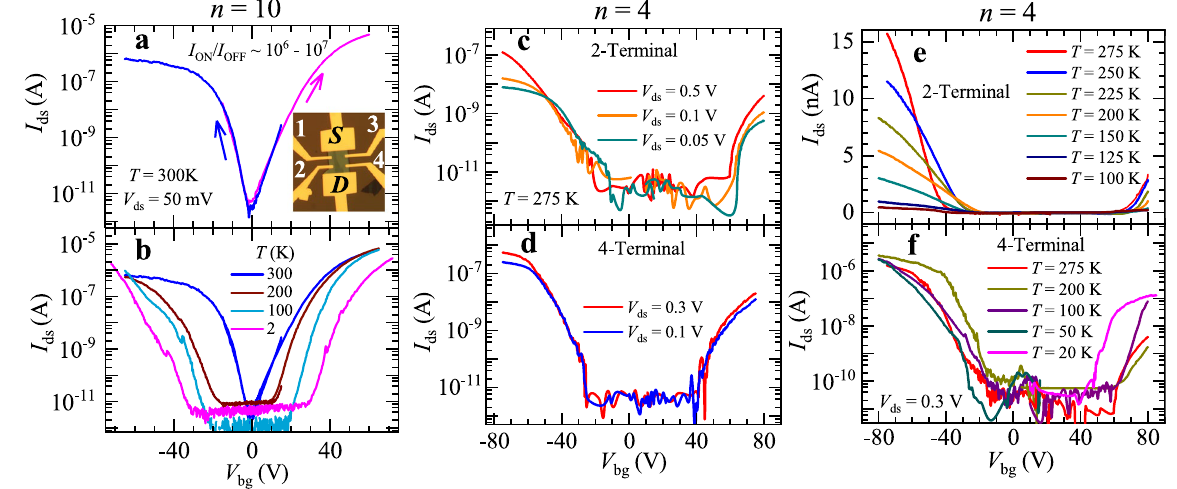
Figure 2. ( a) Drain to source current I ds as a function of the gate-voltage V bg for a ten layer thick ReSe 2 crystal. Blue (magenta) markers depict decreasing (increasing) gate-voltage sweeps. Notice the near absence of hysteresis. Both traces were acquired at room temperature under a bias voltage of V ds = 50 mV. Inset: picture of the FET indicating the configuration of contacts. Source (S) and drain (D) contacts were used for two terminal measurements. The channel length and width of the device was 11.6 μ m and 10.9 μ m respectively. ( b ) I ds as a function of V bg for the same sample and for several temperatures ranging from T = 300 K to 2 K. Notice the progressive emergence of a threshold gate-voltage which increases upon decreasing T . ( c ) Drain to source current I ds for a n = 4 sample as a function of the back-gate voltage V bg in a semi-logarithmic scale for several values of the bias voltage V ds, measured at T = 275 K through a two-terminal configuration. ( d ) Same as in ( c ) but measured via a four-terminal configuration. ( e ) I ds as a function of V bg for several temperatures measured via a two-terminal configuration in a linear scale. ( f ) Same as in ( e ) but in a logarithmic scale and measured through a four-terminal configuration. For both panels (e) and (f) a bias voltage V ds = 0.3 V was used.